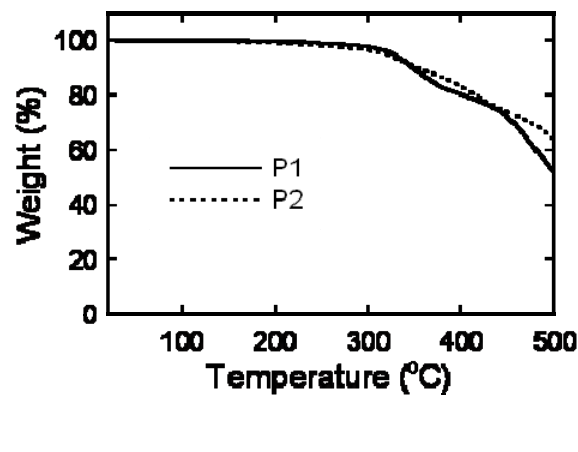
Figure 4. Thermogravimetric analysis of P1 and P2 at a heating rate of 10 °C min − 1 under flowing N 2